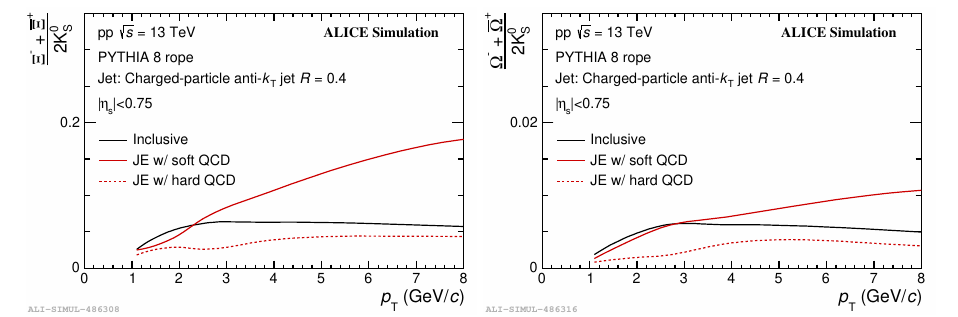
+ ) / 2K 0 (right) ratios obtained from S